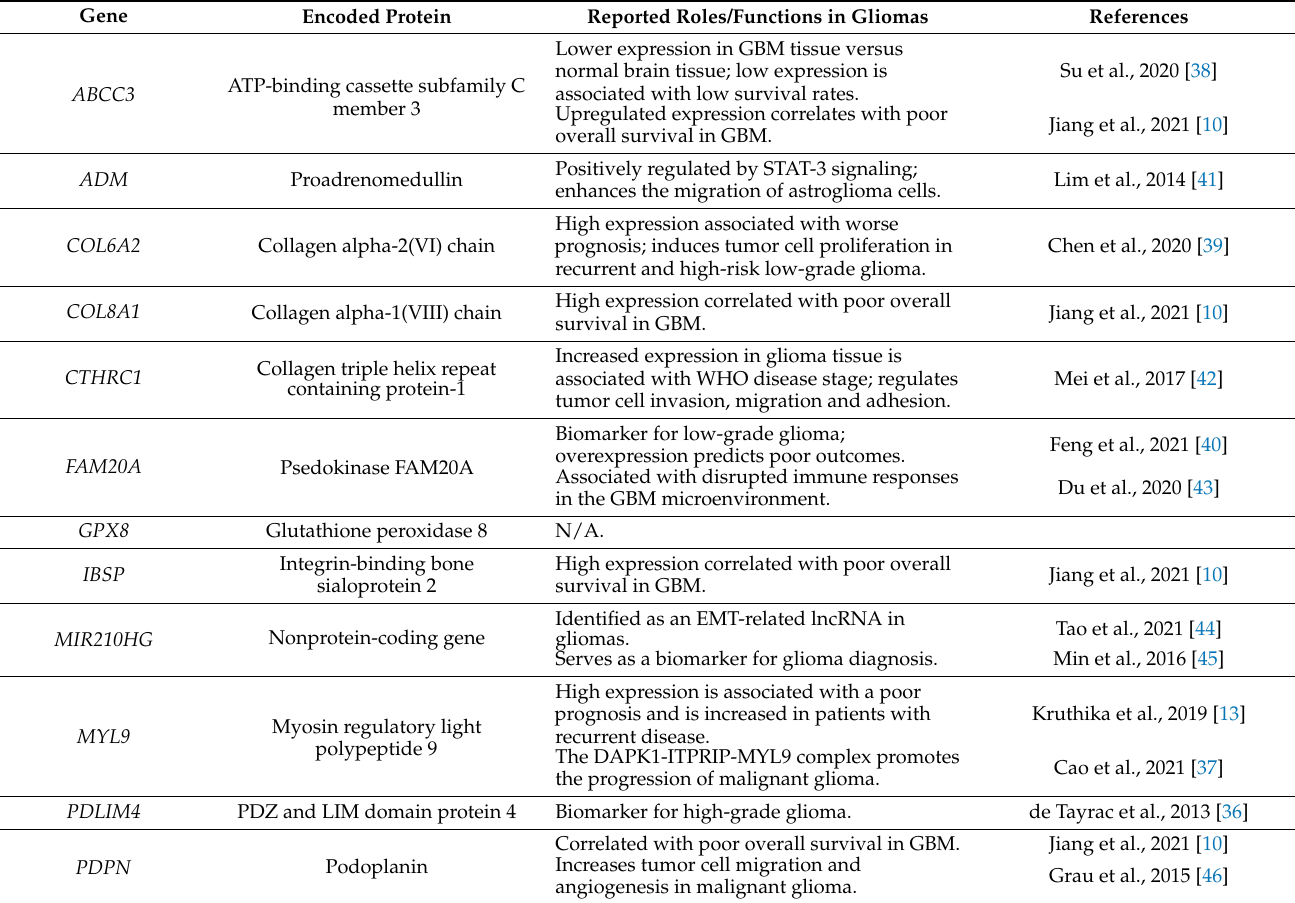
Table 3. Roles/functions of overexpressed GBM gene signatures in